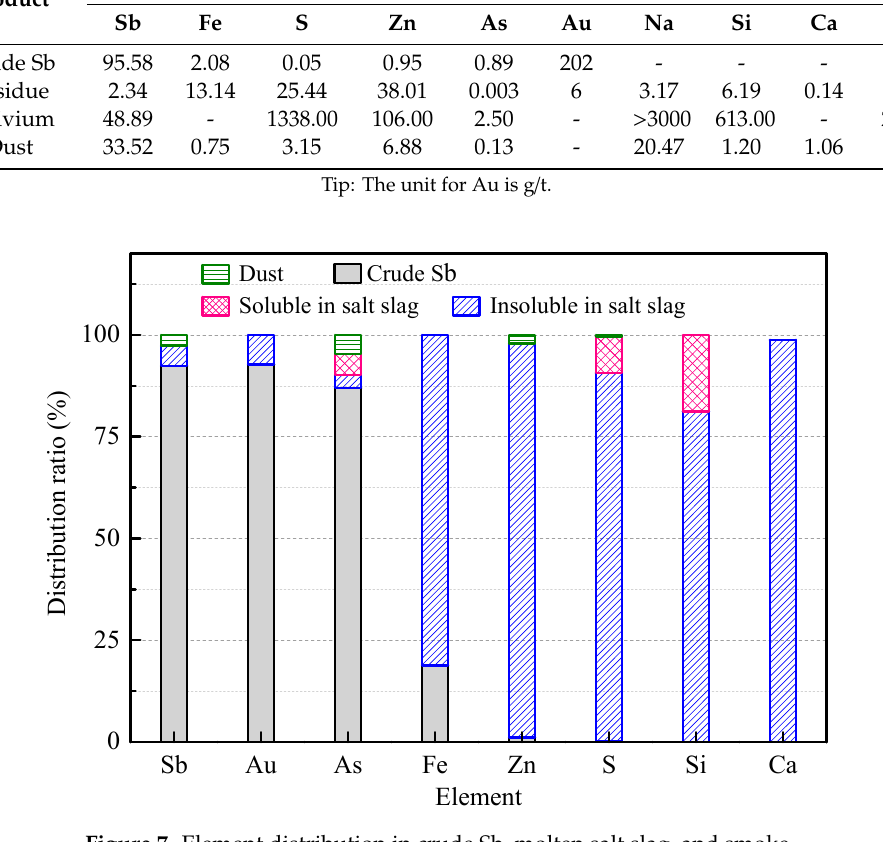
Figure 7. Element distribution in crude Sb, molten salt slag, and smoke.